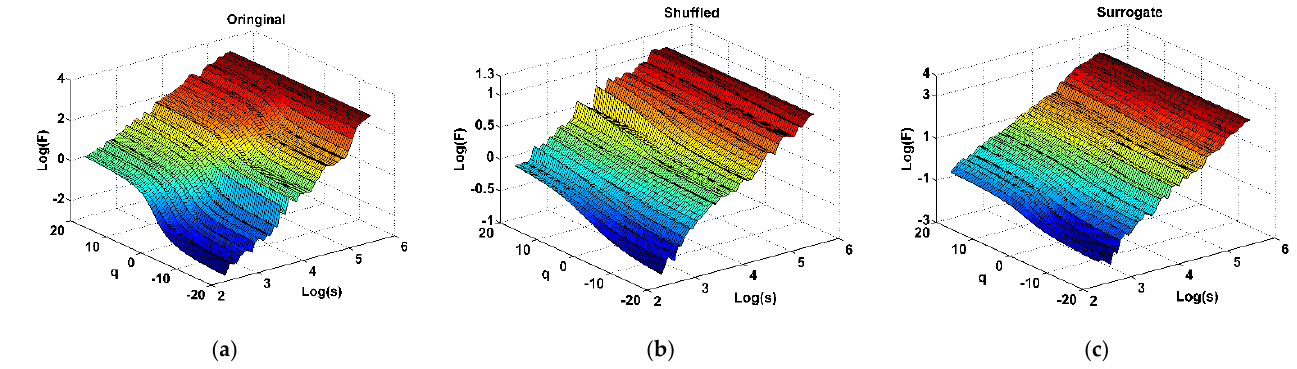
Figure 3. The surface of fluctuation functions ln ( F x 1 for ( a ) original pollutants time series, ( b ) shuffled pollutants time series and ( c ) surrogate pollutants time series in Zhengzhou, where q ranges from − 20 to 20.